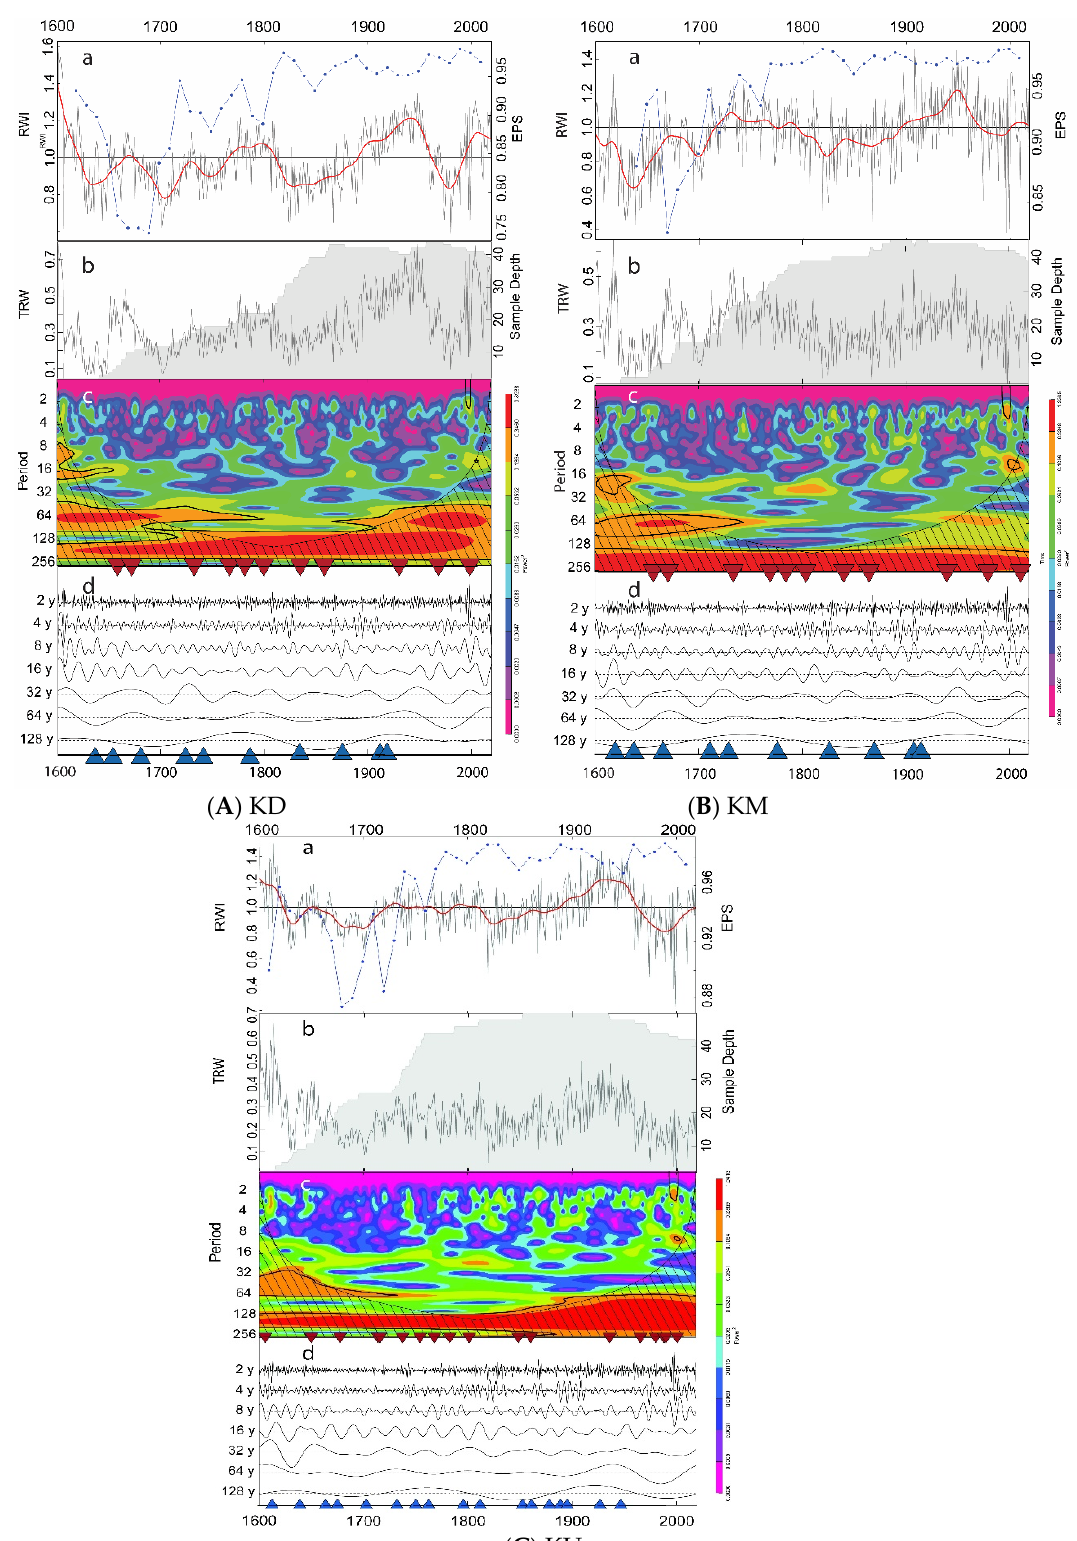
Figure 3. ( A – C ) The three study sites—KD, KM and KU: ( a ) the detrended ring width (RWI, grey line), 20-year spline (red line) and EPS (blue dots); ( b ) the raw TRW and sample depth; ( c ) the Morlet power spectrum; and ( d ) the multiresolution decomposition of TRW and pointer years (red triangle—negative year, blue triangle—positive year).